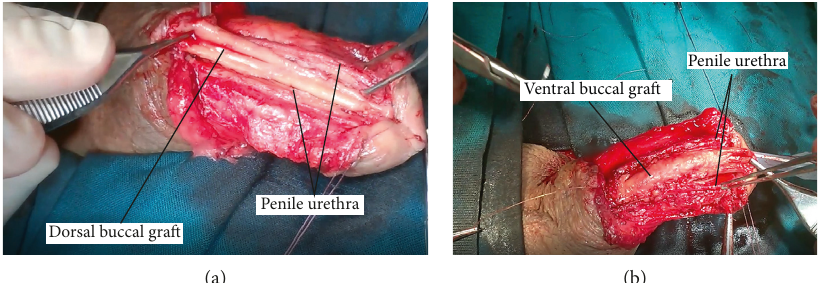
Figure 1: (a) Suturing the dorsal buccal graft on the tunica albuginea. (b) Placement and suturing in the urethra of the ventral buccal